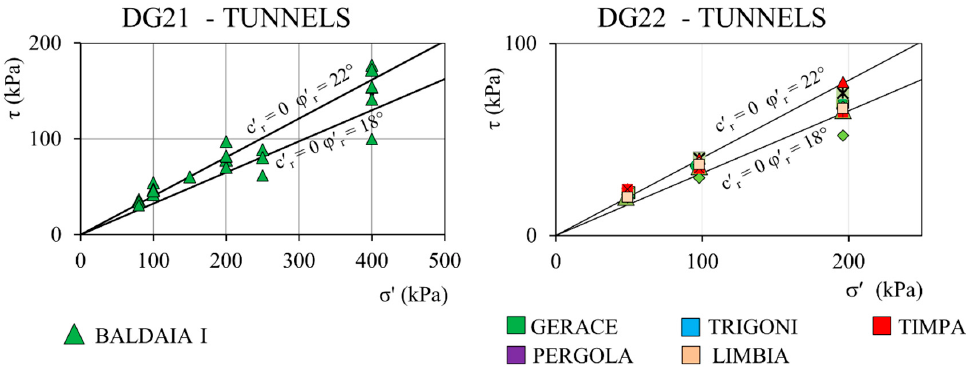
Figure 5. Residual shear strength obtained by direct shear testing on samples from the DG21 and DG22 maxi